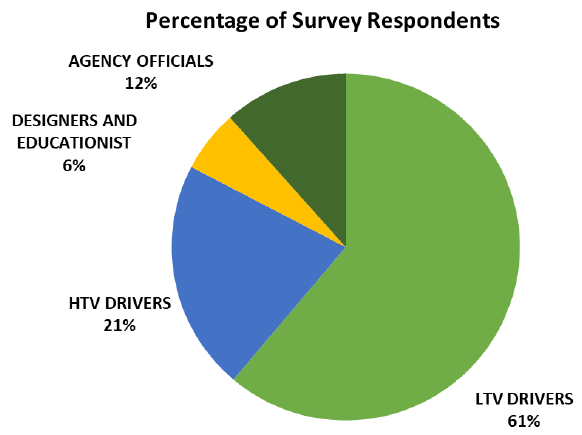
Figure 2. Percentage of Survey Respondents.